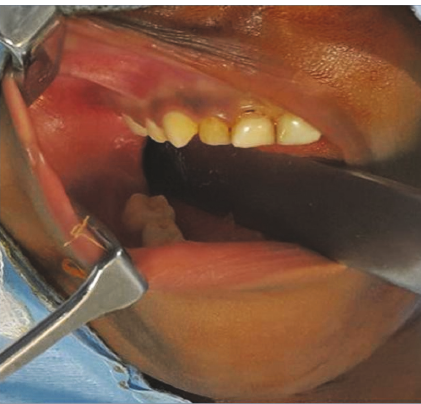
Figure 1: Intraoral examination reveals the obliteration of buccal sulcus adjacent to molar teeth with buccal and lingual cortical expansion.